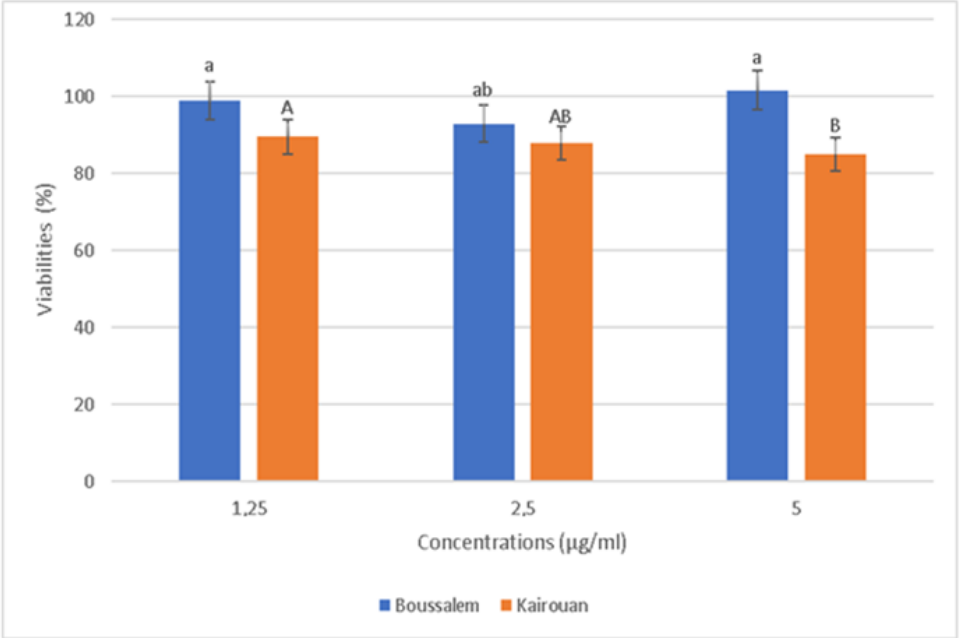
Figure 4. Evolution of cell viability as a function of the concentrations of lemon verbena extracts in different collection regions. Percentages with different letters (a,A,b,B) were significantly different at p < 0.05.